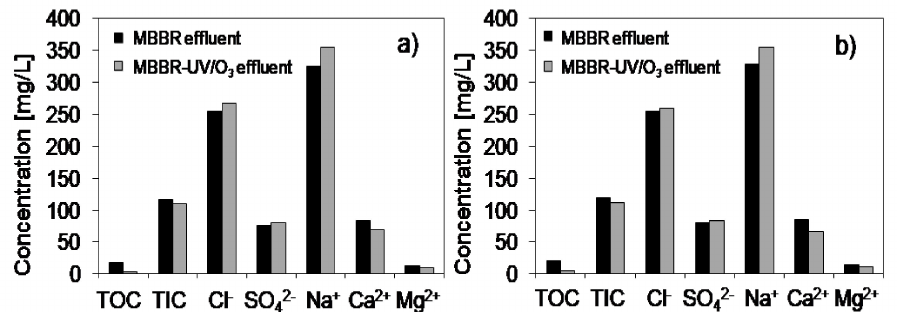
Figure 6. Influence of UV / O 3 pretreatment on MF permeate quality at VCR = 2 ( a ) and 10 ( b